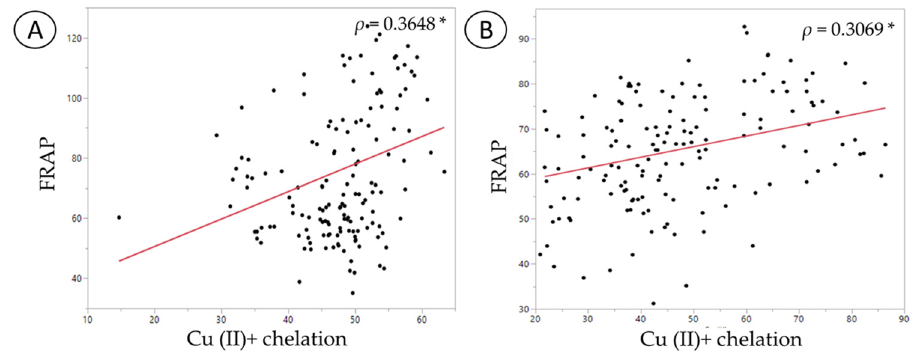
Figure 6. Spearman’s correlation analysis between FRAP and copper chelation ability: ( A ) Normal fecal sample; ( B ) C. difficile -infected fecal sample. The symbol * represents significant correlation ( p < 0.05).